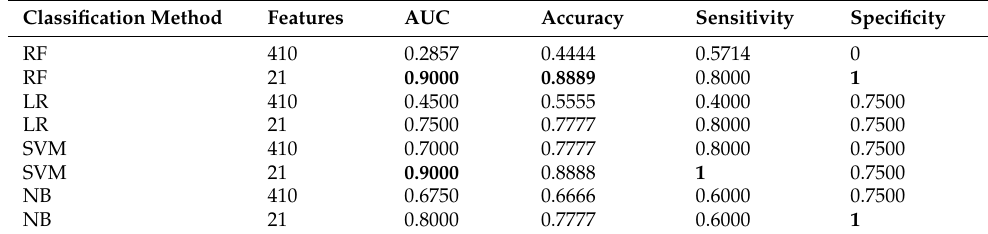
Table 3. Evaluation metrics for each classifier of the standardized dataset.